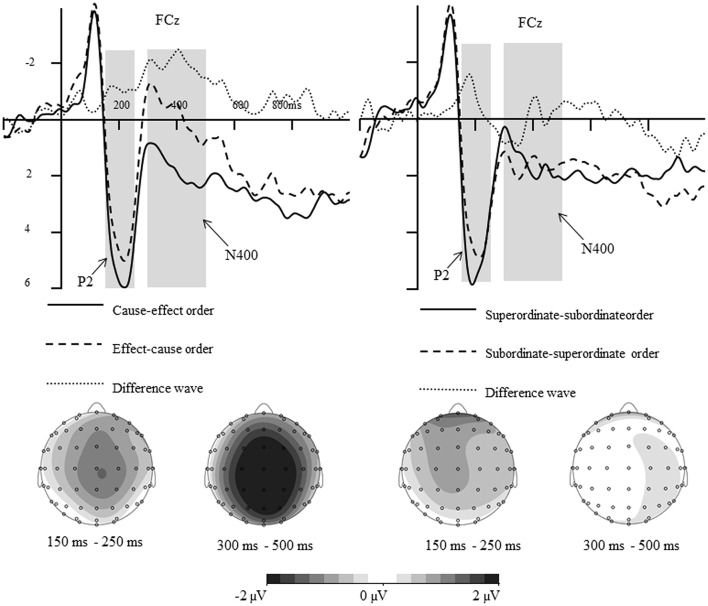
Difference waves and topographical maps for different conditions (Left: Effect-cause order subtracts cause-effect order for causally related stimuli; Right: Subordinate-superordinate level order subtracts superordinate-subordinate level order for hierarchically related stimuli).